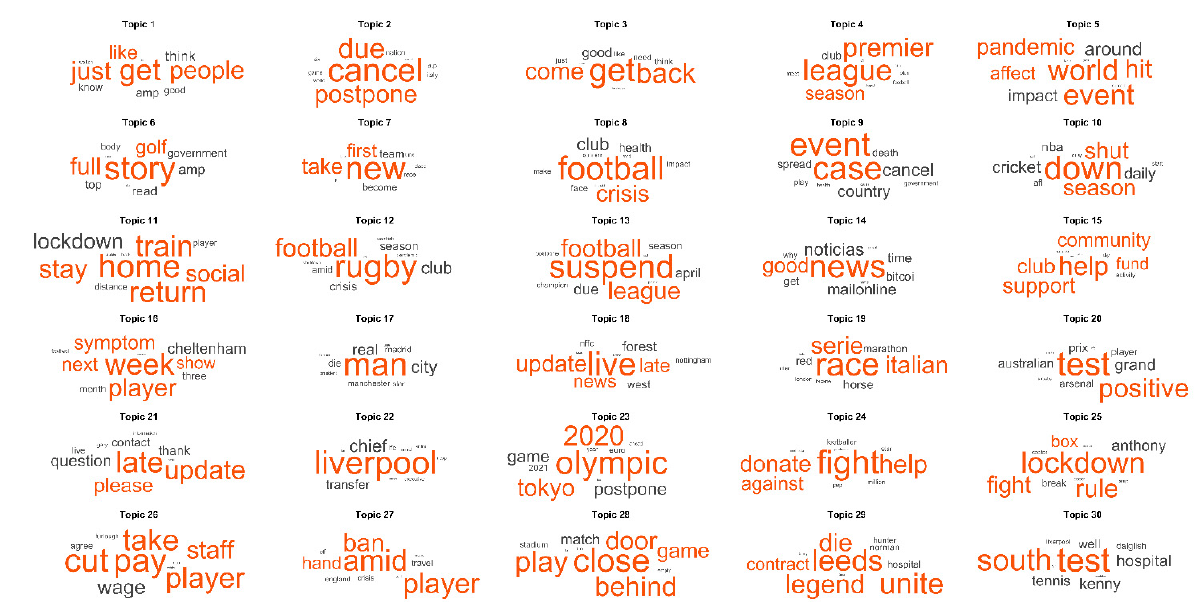
Figure 6. Representative words of the topics found in the LDA model. A larger size represents a higher probability of appearing in the documents associated with each topic. Words with a lower probability appear in a smaller size (for words with a lower probability, see Table S3) .